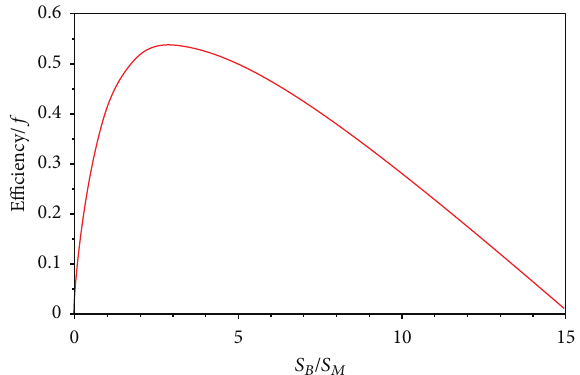
Figure 2: The maximum efficiency of the power plant (divided by f ) is plotted as a function of the ratio between 𝑆 𝐵 and 𝑆 𝑀 . The optimal efficiency of 𝑓 ⋅ 0.54 is reached for 𝑆 𝐵 ≈ 3 ⋅ 𝑆 𝑀